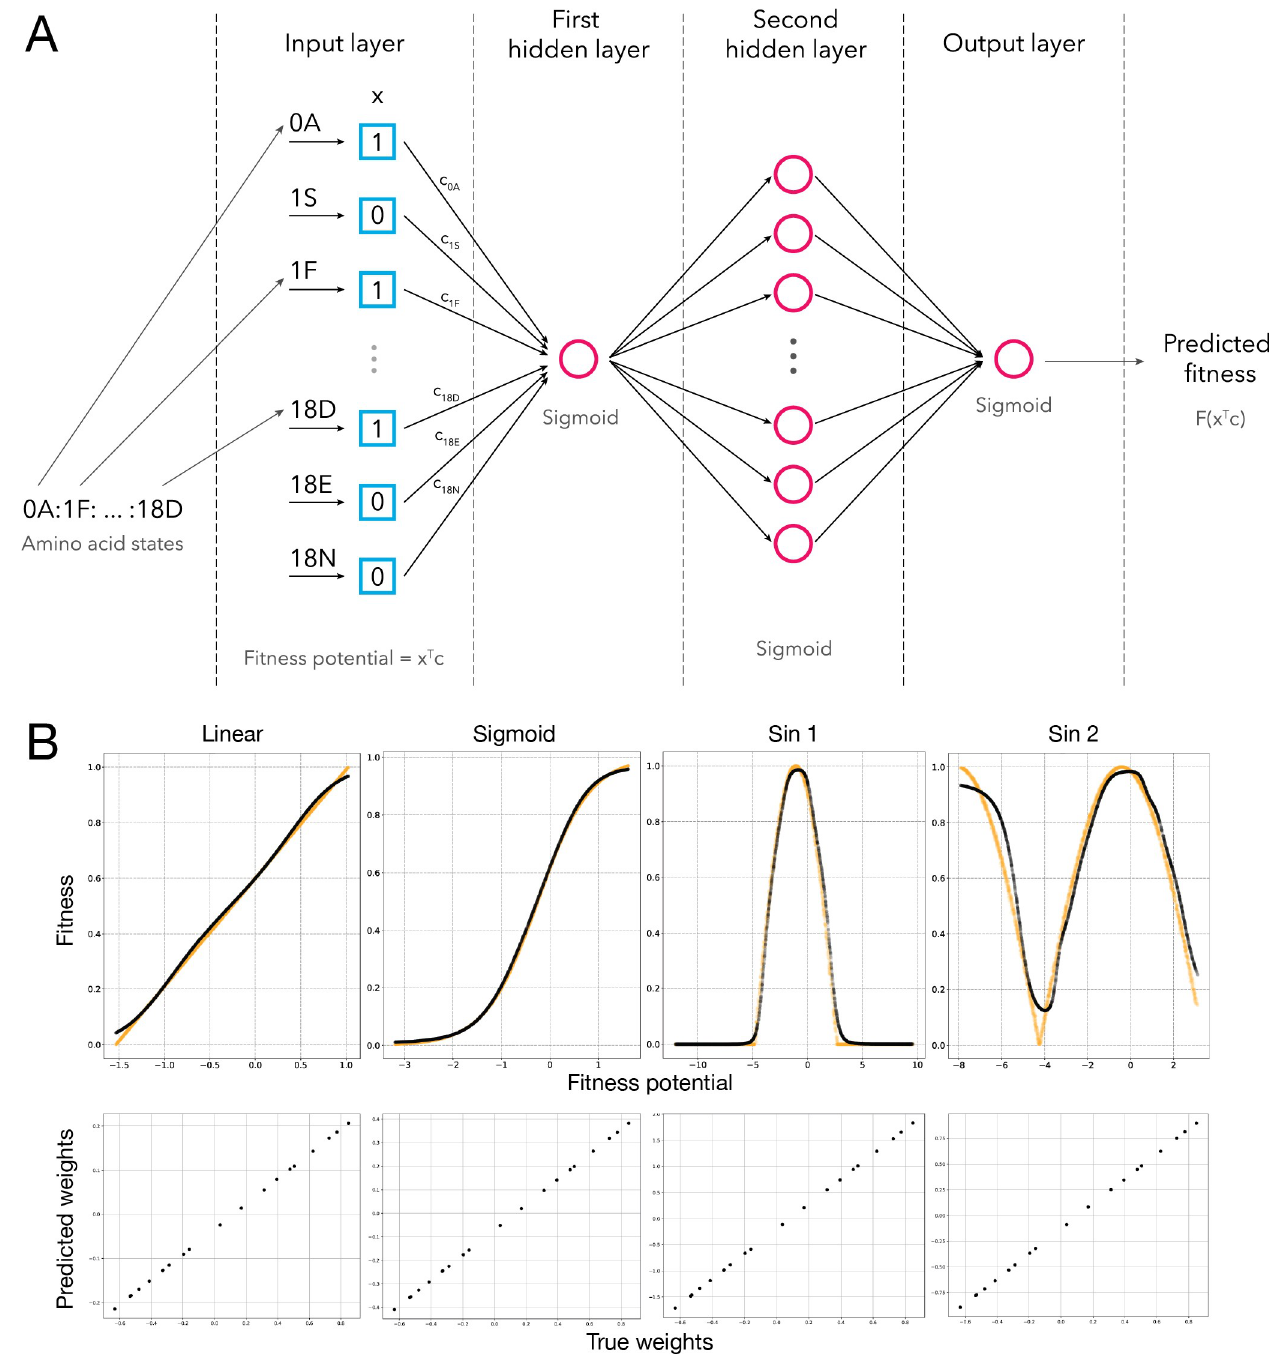
Fig 4. Schematic representation of a deep learning approach able to fit any arbitrary fitness function. a, each genotype was encoded as a binary vector (x). During training, each of the amino acid replacements was assigned a coefficient (c i ), comprising a vector of coefficients (c). The multiplication of these two vectors is the fitness potential of the genotype. After going through three layers, each with a sigmoid activation function, the predicted fitness is obtained. b, The fit of a mock fitness function (yellow) and the fit achieved by our neutral network (black). The mock fitness function was created by generating a set of amino acid states with defined coefficients (effects on fitness potential), which were then combined to generate genotypes across a range of fitness potential values.